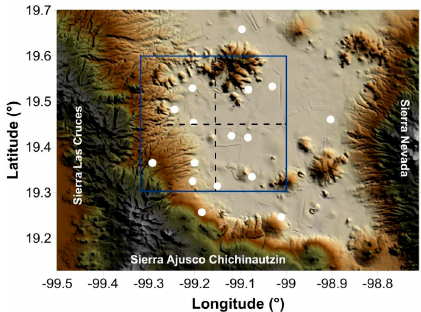
Figure 2. Study domain for Mexico City and spatial distribution of the stations (white dots) of the wind-monitoring network (REDMET) of the atmospheric monitoring network of Mexico City (SIMAT). The REDMET provides 1-hour average values of wind speed and wind direction, and other properties such as temperature and relative humidity.